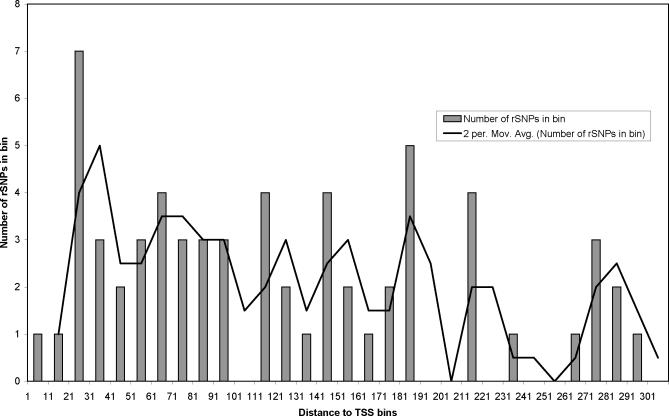
Histogram of Positional Bias of rSNPs for the First 300 bp of SequenceThe positions of rSNPs are plotted in a histogram for bin sizes of 10 bp for the first 300 bp of sequence from the TSS. A blip is seen at position 21–31, where it is likely that TATA and CCAAT box–binding sites are located. These types of rSNPs, however, are only slightly overrepresented in this study and from this graph are not expected to significantly bias the outcome.